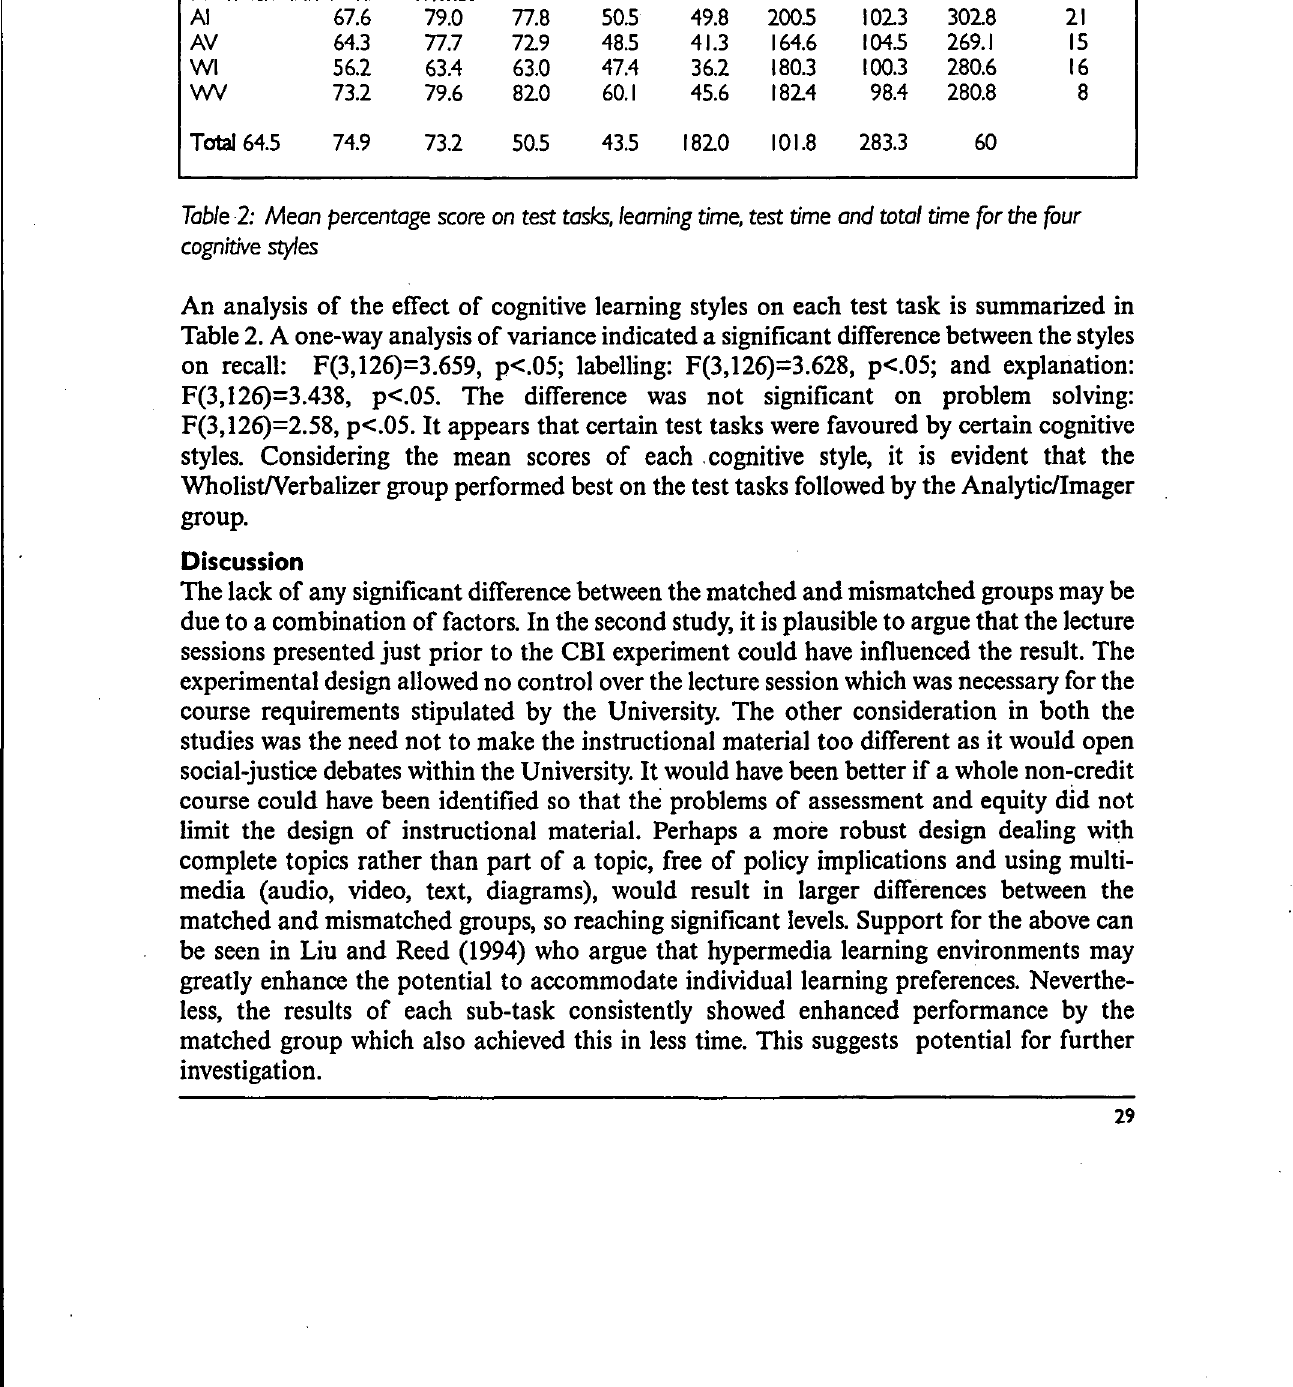
Table 2: Mean percentage score on test tasks, learning time, test time and total time for the four cognitive